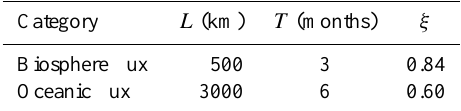
Table 1. Covariance parameters in Eq. (3) for different categories.